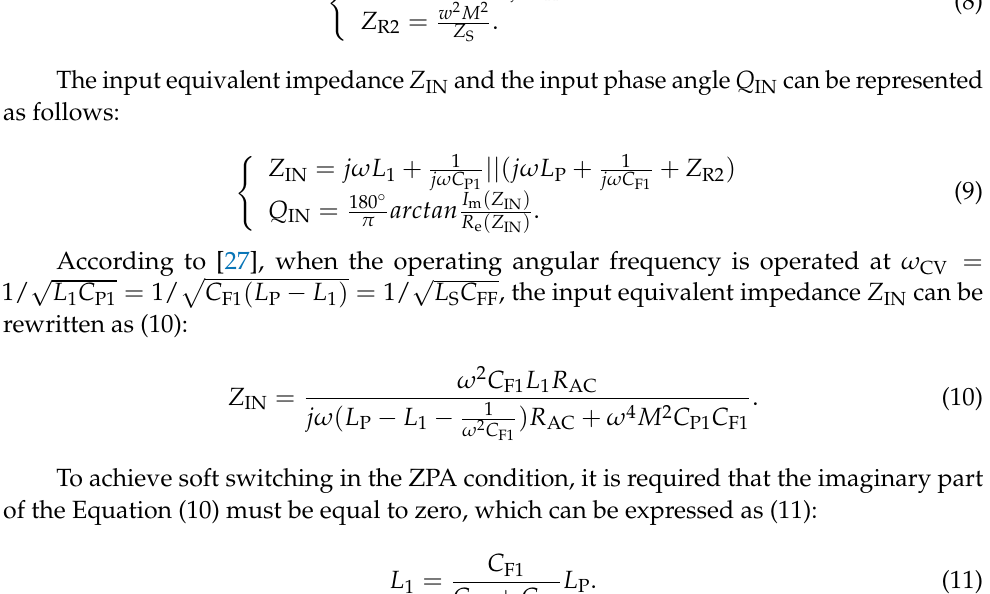
Figure 8. Primary side circuit diagram of the LCC-S topology with reflected impedance.